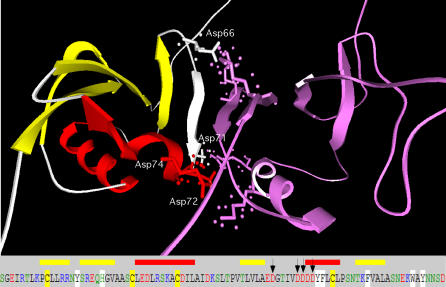
NORSnet Captured Unstructured Regions Related to High Net Charge/Low HydrophobicityDFF45 (white, yellow, and red) becomes structured upon complex formation with DFF40 (purple; [55]). The interface includes a buried hydrophobic patch surrounded by hydrophilic interactions. Usually, charged residues disrupt the formation of tertiary structure; in this case, however, when the complex is formed, the negative charge of the Asp groups in DFF45 is cancelled out, with the positive charges of DFF40 allowing the protein to be folded. Visualization was done using GRASP2 [85]. Since DFF45 has high secondary structure content, it is a relatively hard target for NORSnet prediction. However, NORSnet correctly identified its unstructured region at a rather stringent cutoff.